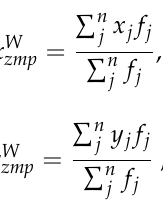
( c ) Figure 5. Results of stability indices and CP detected from the robot walking simulation (red line: COG, blue line: ZMP, and black line: CP): ( a ) Traces of stability indices and the CP in x y -axis; ( b ) results of stability indices in x -axis (walking forward); ( c ) results of stability indices and the CP in y - axis (toward left and right). In summary of simulation, the x CP resembles the x COG in the sagittal plane excepting for the sharp rising period of value. This sharp increasing period is caused by the radical changeable speed of swing limb. In the transverse plane, the y CP is different from the y COG , since it is affected by the altered speed and trace of swing limb and the changeable rotation in the hip joints.